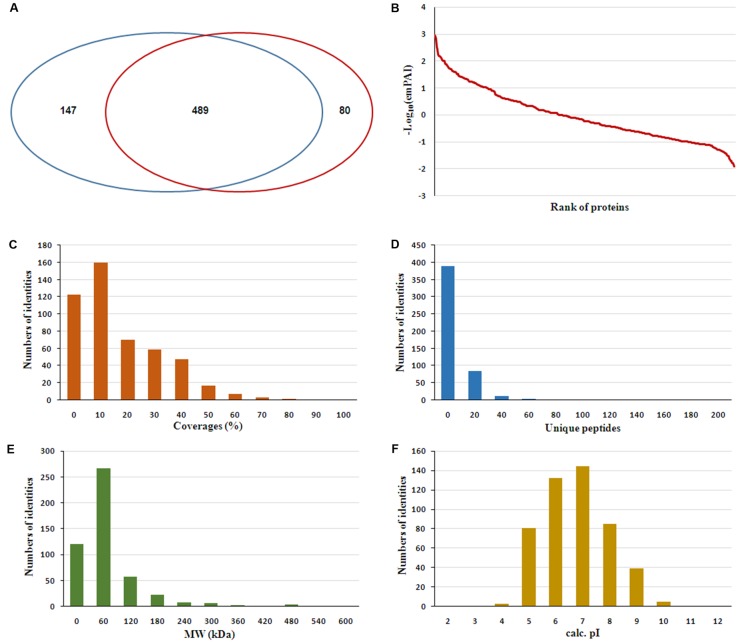
Features of the serum proteome dataset from iTRAQ shotgun analysis. (A) Venn diagrams displaying the number of identified proteins and the overlay of these identified proteins. (B) Analysis of ranges of Mascot emPAI value for protein abundance. (C) Distribution of proteins based on peptide coverage. (D) Distribution of proteins based on the number of unique peptides in the proteomics analysis. (E) Distribution of proteins based on molecular weight (MW). (F) Distribution of proteins based on pI.